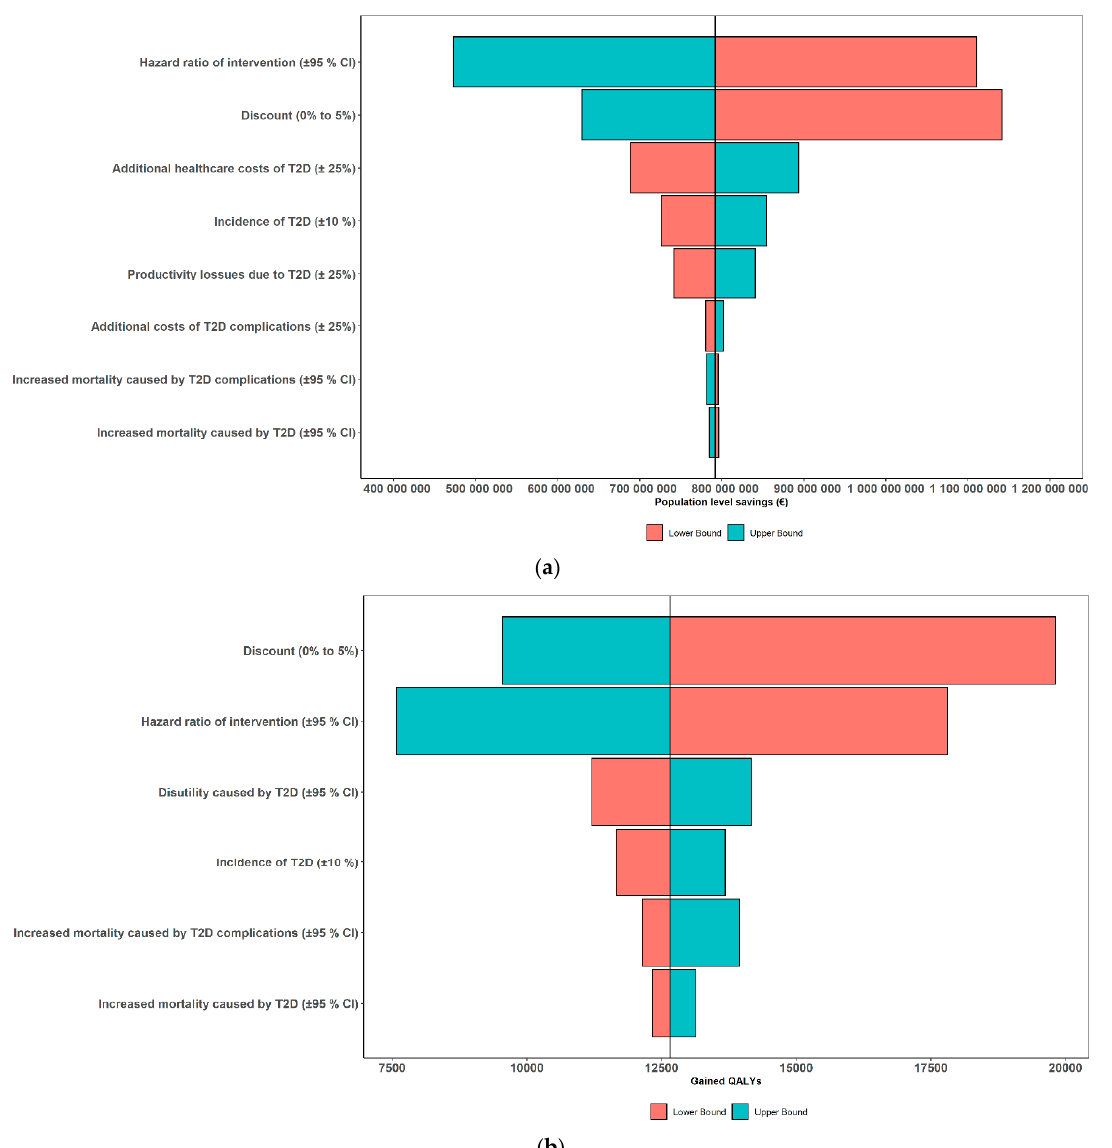
Figure 2. Tornado diagrams showing the results of one-way sensitivity analyses in terms of ( a ) cost savings and ( b ) additional QALYs in Scenario I (i.e., 10%-unit increase in the proportion of Finnish adults with the daily use of whole grain foods) with the 20-year timeframe as an example.